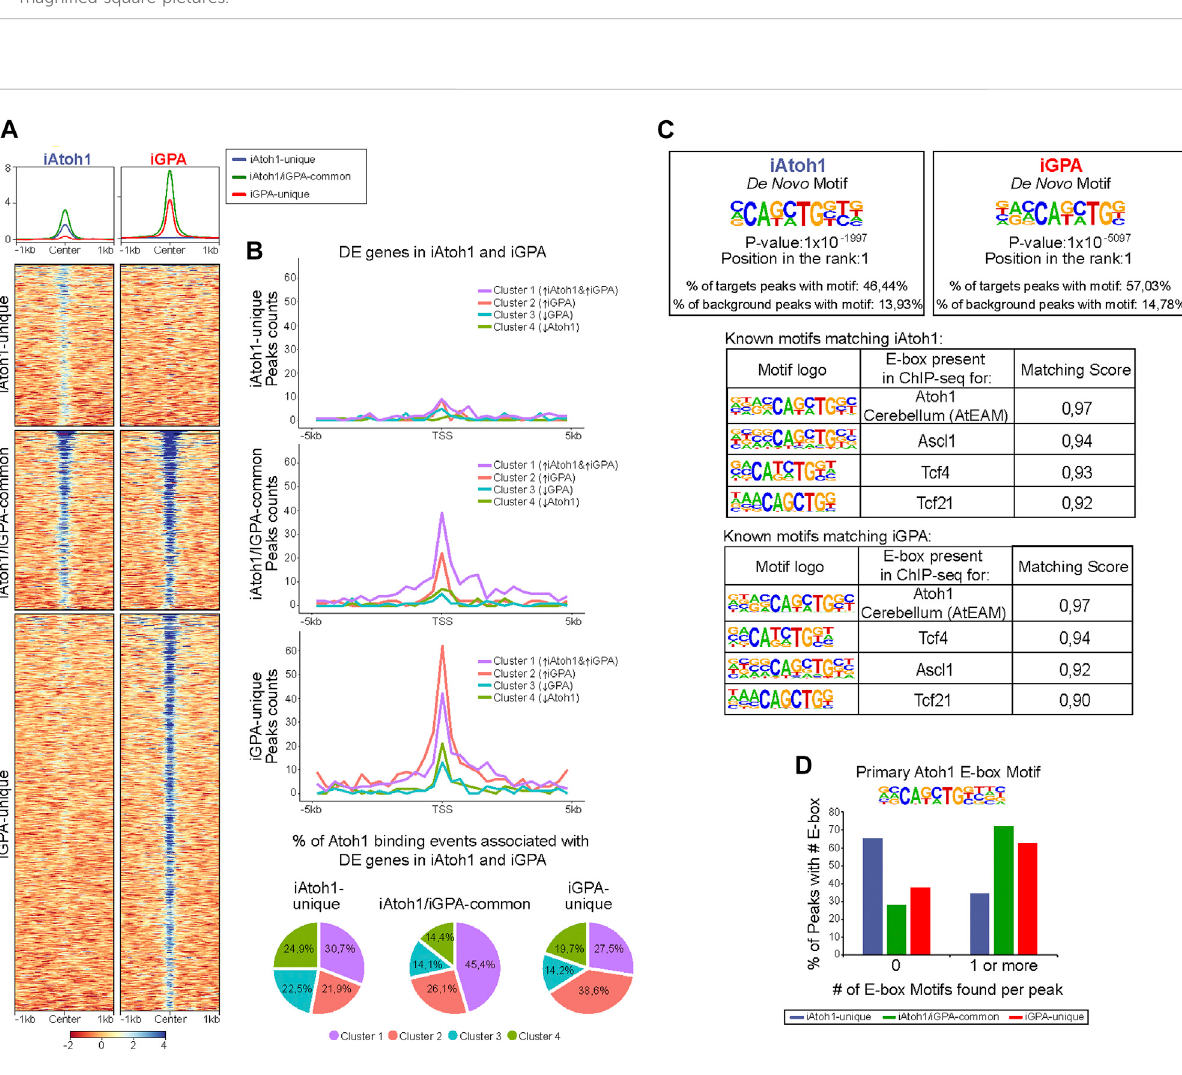
G fi 1+Pou4f3promoteAtoh1bindingtoitspreferredmotifatnewgenomiclocationswithoutinhibitingbindingtoitsoriginaltargets. (A) Density heatmaps of Atoh1 Chip-seq datasets from iAtoh1 and iGPA EBs at 48 h post-induction of TF overexpression. Each column shows the Atoh1 ChiP- seq signal for iAtoh1 and iGPA lines which are divided by the three different Atoh1 peak groups identi fi ed in (Supplementary Figure S4A). Each row represents the normalized counts (reads per kilobase per million, RPKM) for Atoh1 ChIP-seq peak signal spanning ± 1 kb from the centre of the peak. (B) Plot representing the total peaks counts found ± 5 Kb around the transcription start site (TSS) for the previously identi fi ed gene clusters in iAtoh1 and iGPA RNA-seq datasets (Figure 1E). Peak counts were dividedinto three groups (iAtoh1-unique, iAtoh1/iGPA-common and iGPA-unique) showninthreeseparatedplots.Thenumberofpeaksfoundforeachgeneclusterwasdividedbythetotalnumberofpeaksofeachcategorytoobtain the%Atoh1bindingassociatedwithDEgenesofiAtoh1andiGPAEBsrepresentedinpiecharts. (C) MotifsanalysesforAtoh1peaksiniAtoh1andiGPA EBs. Upper: the most signi fi cant de novo motif detected in iAtoh1 and iGPA by searching at 250 bp regions centred at summits; lower: best match betweenknownmotifsandmotifsfoundinAtoh1peaksshowsthatthepreviouslydetectedAtoh1motifincerebellum(AtEAM)hasthehighestmatch score in both iAtoh1 and iGPA EBs. (D) Graph showing the number of AtEAM motifs found in each Atoh1 peak group: iAtoh1-unique, iAtoh1/iGPA- common and